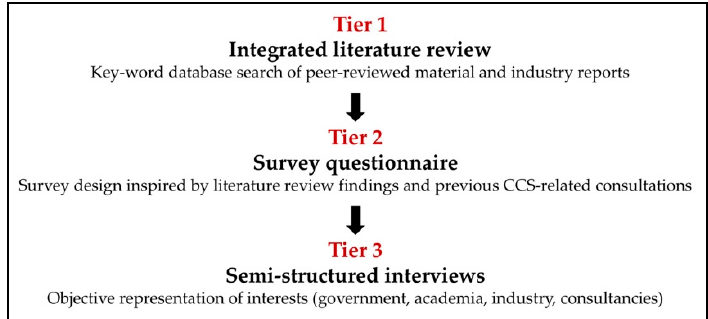
Figure 1. Qualitative multi-method research approach.